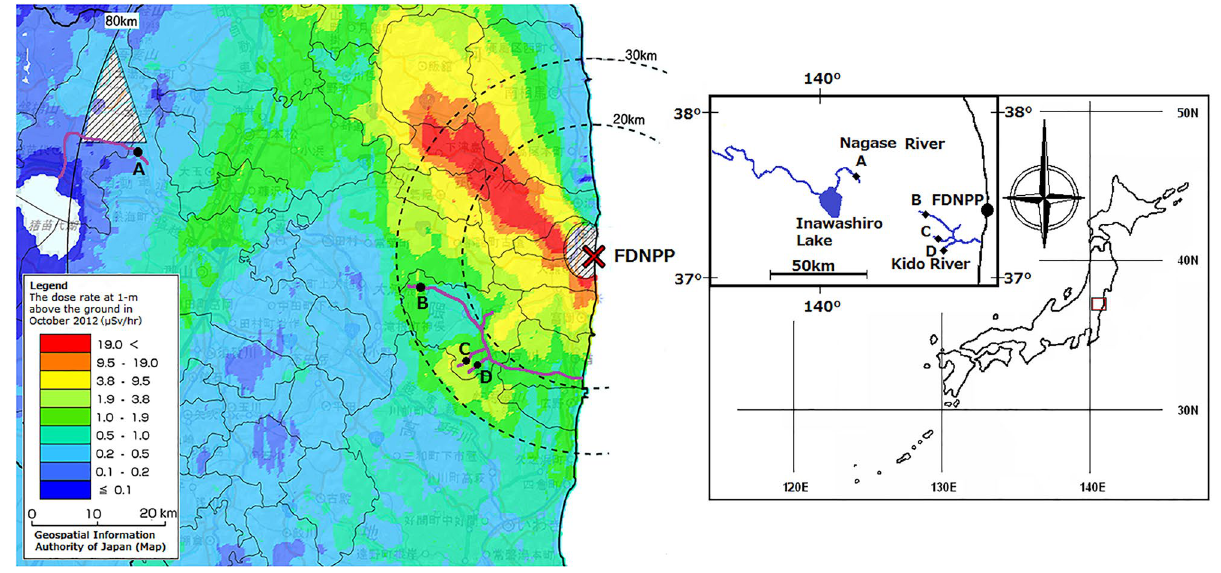
Figure 1. Study site in Fukushima Prefecture, Japan. Square: sampling sites, circle: FDNPP (Fukushima Daiichi Nuclear Power Plant). This map was generated by using software program Microsoft Paint Windows